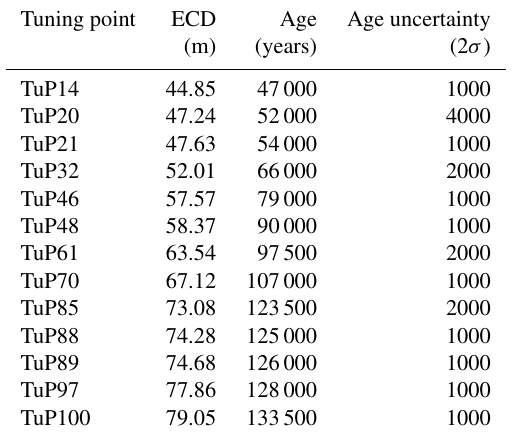
Table 5. Tuning points obtained by dynamic time warping align- ment of the Orakei RPI data to the PISO-1500 VADM (Channell et al.,